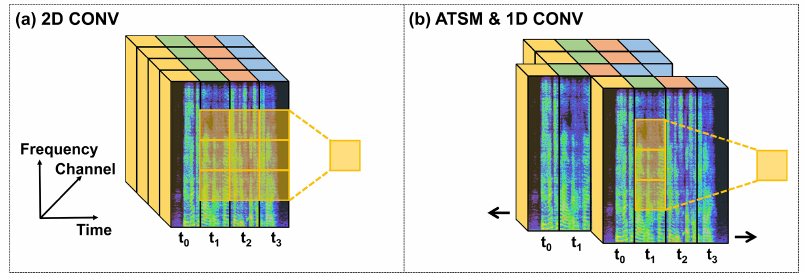
Figure 4. To enable information flow through t 1 , t 2 , t 3 , we can use ( a ) a 2D convolutional layer or ( b ) the proposed ATSM with a 1D convolutional layer. The latter is more